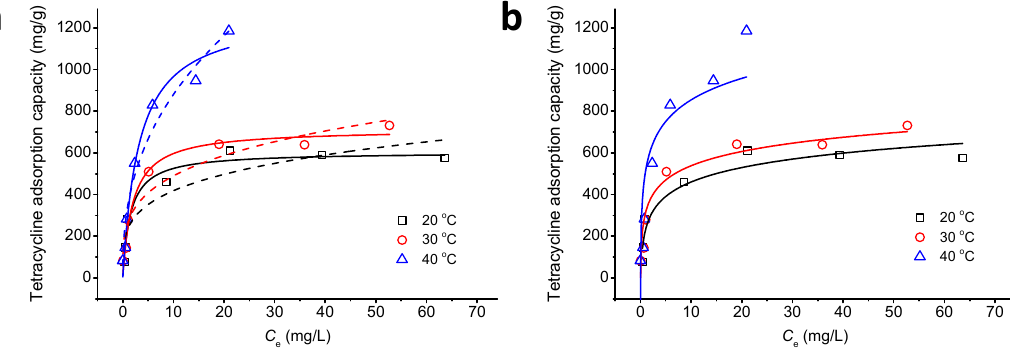
Figure 7. ( a ) Langmuir (solid lines) and Freundlich (dashed lines) and ( b ) Temkin adsorption isotherms for TC adsorption onto Fe 3 O 4 @GO at various temperatures. pH = 4.0, m / V = 70 g/L, C 0(TC) = 10 mg/L, T = 303 K, t = 24 h. Table 2. The isotherm parameters for TC adsorption onto Fe 3 O 4 @GO.